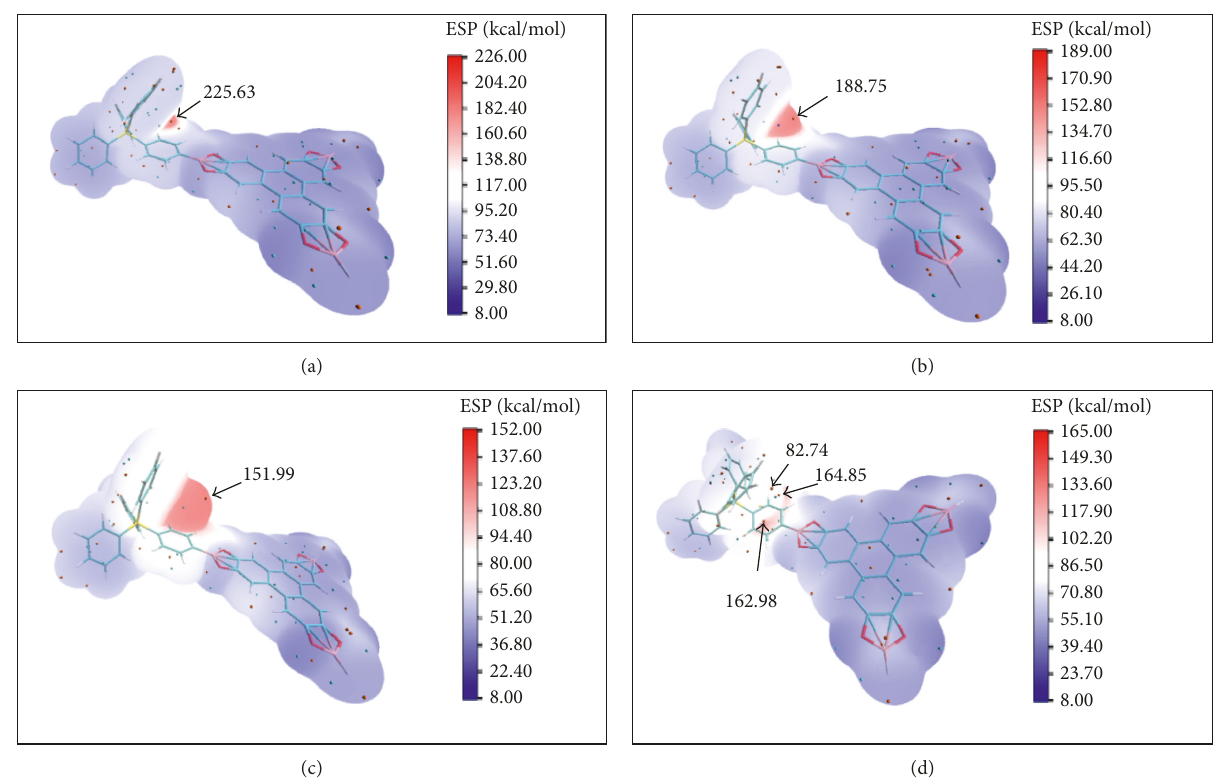
Figure 3: Electrostatic potential distribution of all the metal-doped complexes (metal@COF-105). (a) Li@COF-105. (b) Na@COF-105. (c) K@COF-105. (d)